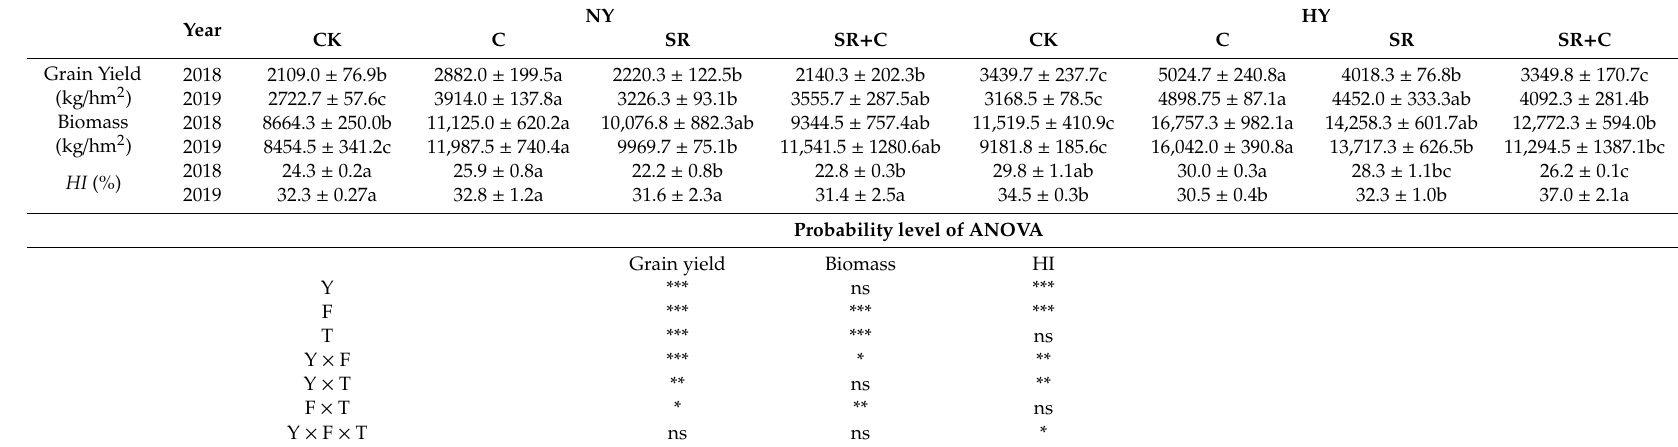
Table 3. E ff ects of biochar and soft rock application treatments on grain yield and related agronomic traits of millet under two fertilizer